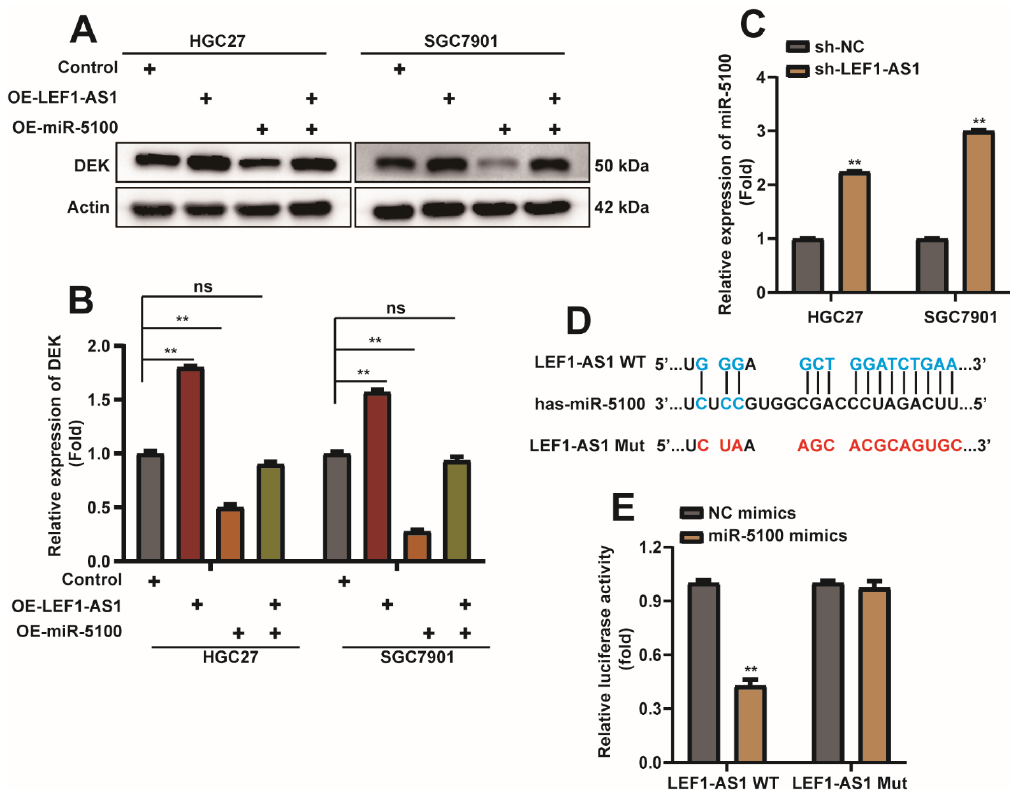
Figure 9. LEF1-AS1 sponge adsorbs miR-5100 and regulates the expression of miR-5100. ( A , B ) Western Blot detection of DEK protein when OE-LEF1-AS1 + mimics-NC/miR-5100 mimics + OE-NC/5100 mimics + OE-LEF1-AS1 was transfected into HGC27 and SGC7901 cells, and co-transfected with mimics -NC and OE-NC were used as controls. Quantitative analysis of experimental results was normalized with Actin. ( n = 3, **: p < 0.01). ( C ) qPCR was used to detect the expression level of mIR-5100 in HGC27- sh-LEF1-AS1 and SGC7901-sh-LEF1-AS1 cell lines, U6 was used as normalization. ( n = 3, **: p < 0.01). ( D ) Schematic diagram of construction of LEF1-AS1-WT and LEF1-AS1-Mut luciferase reporter plasmids. ( E ) LEF1-AS1-WT/Mut and mimics-NC/miR-5100 mimics were co-transfected, and the luciferase reporter assay verified the sponge effect between miR-5100 and LEFAS1 ( n = 3, **: p <